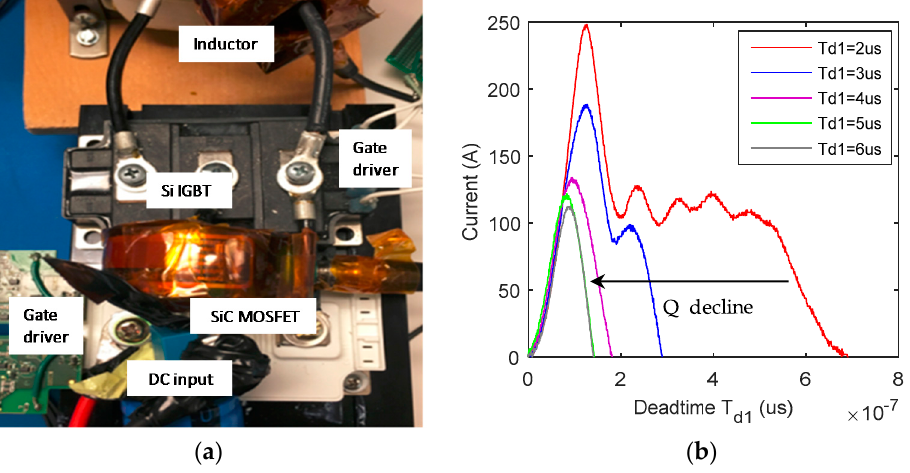
Figure 10. ( a ) Hybrid switches DPT test platform with a different IGBT; and, ( b ) A different IGBT ZCHV turn-off current bumps with various T d1 .